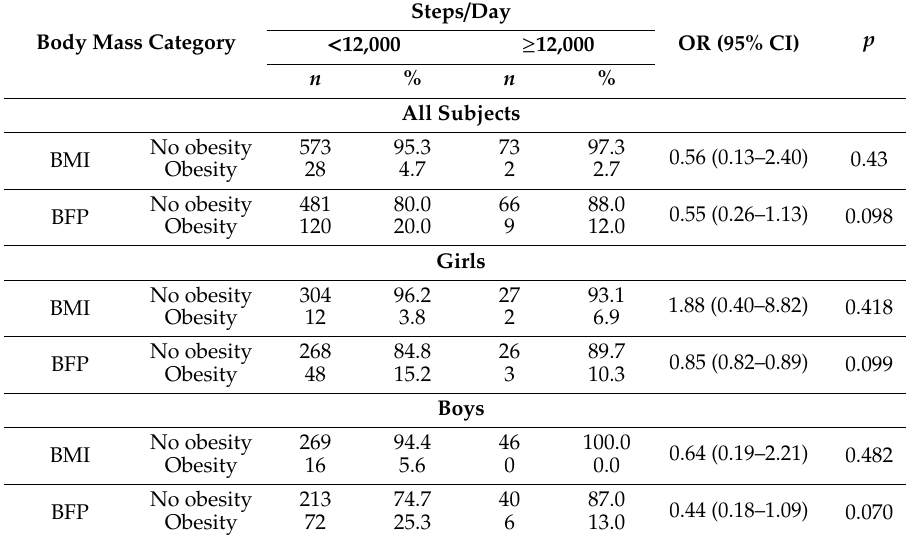
Table 5. Multinomial regression analysis showing the association between the steps per day recommendation and obesity